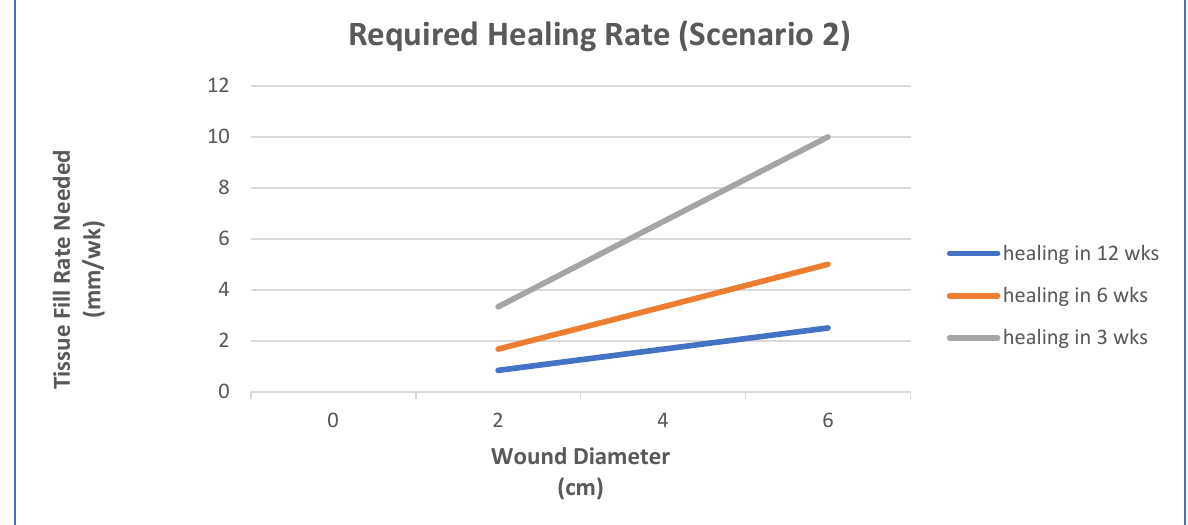
Figure 2. Graph representing healing rate needed if healing is to occur within the specified time for the given wound diameter. This represents scenario 1.